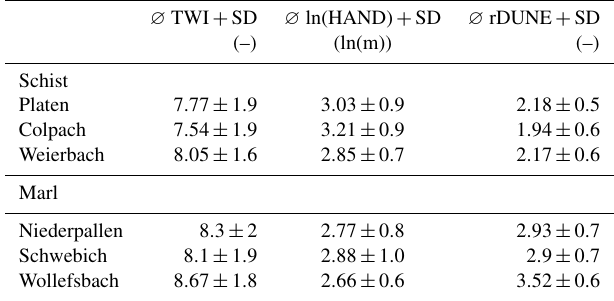
Table 1. Average ( ∅ ) and standard deviation (SD) of the TWI, ln(HAND) and the rDUNE for each experimental